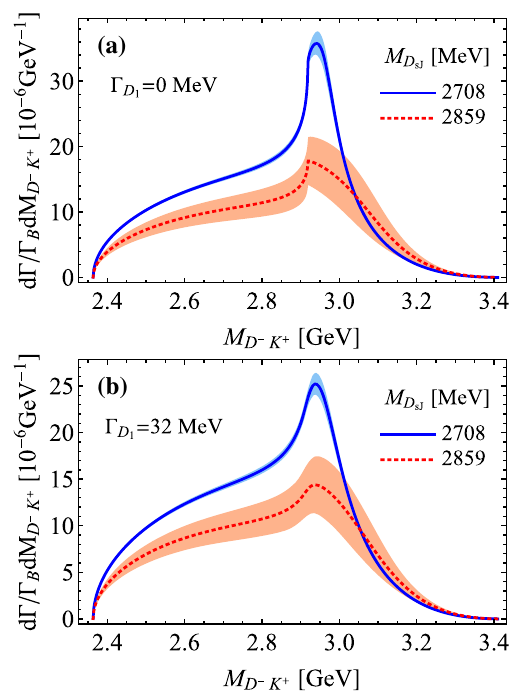
Fig. 3 Invariant mass distribution of D − K + via the rescattering pro- cessesinFig.1b.Themassandwidthofintermediatestate D sJ aretaken ( 2700 ) (solid line) and D ∗ ( 2860 ) (dotted line) given to be those of D ∗ s 1 s 1 by PDG [19], separately. The width of intermediate state ¯ D 1 ( 2420 ) 0 is set to be ( a ) 0 MeV and ( b ) 32 MeV, respectively. The bands are obtained by taking into account uncertainties of the mass and width